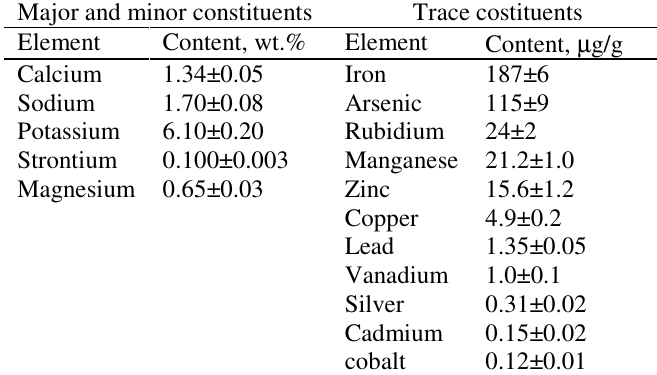
Table 2. Analytical values for NIES certified Reference Material No. 9 "Saragasso"